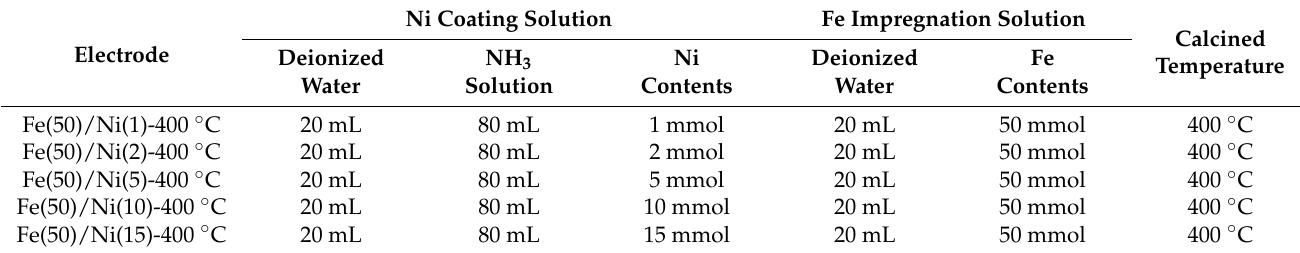
Table 3. Nomenclature of various NiFe electrodes varying with Ni contents.